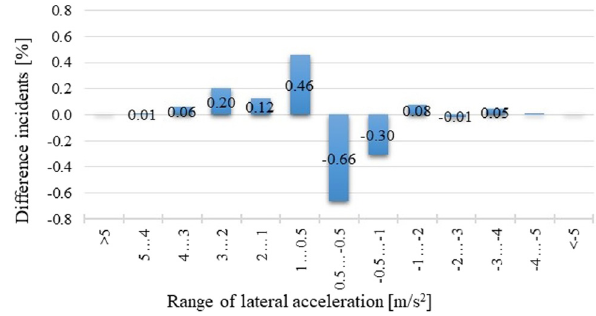
Figure 12: The di ff erence in the frequency of occurrence of particular values of longitudinal acceleration of the afternoon drive in relation to the morning drive.